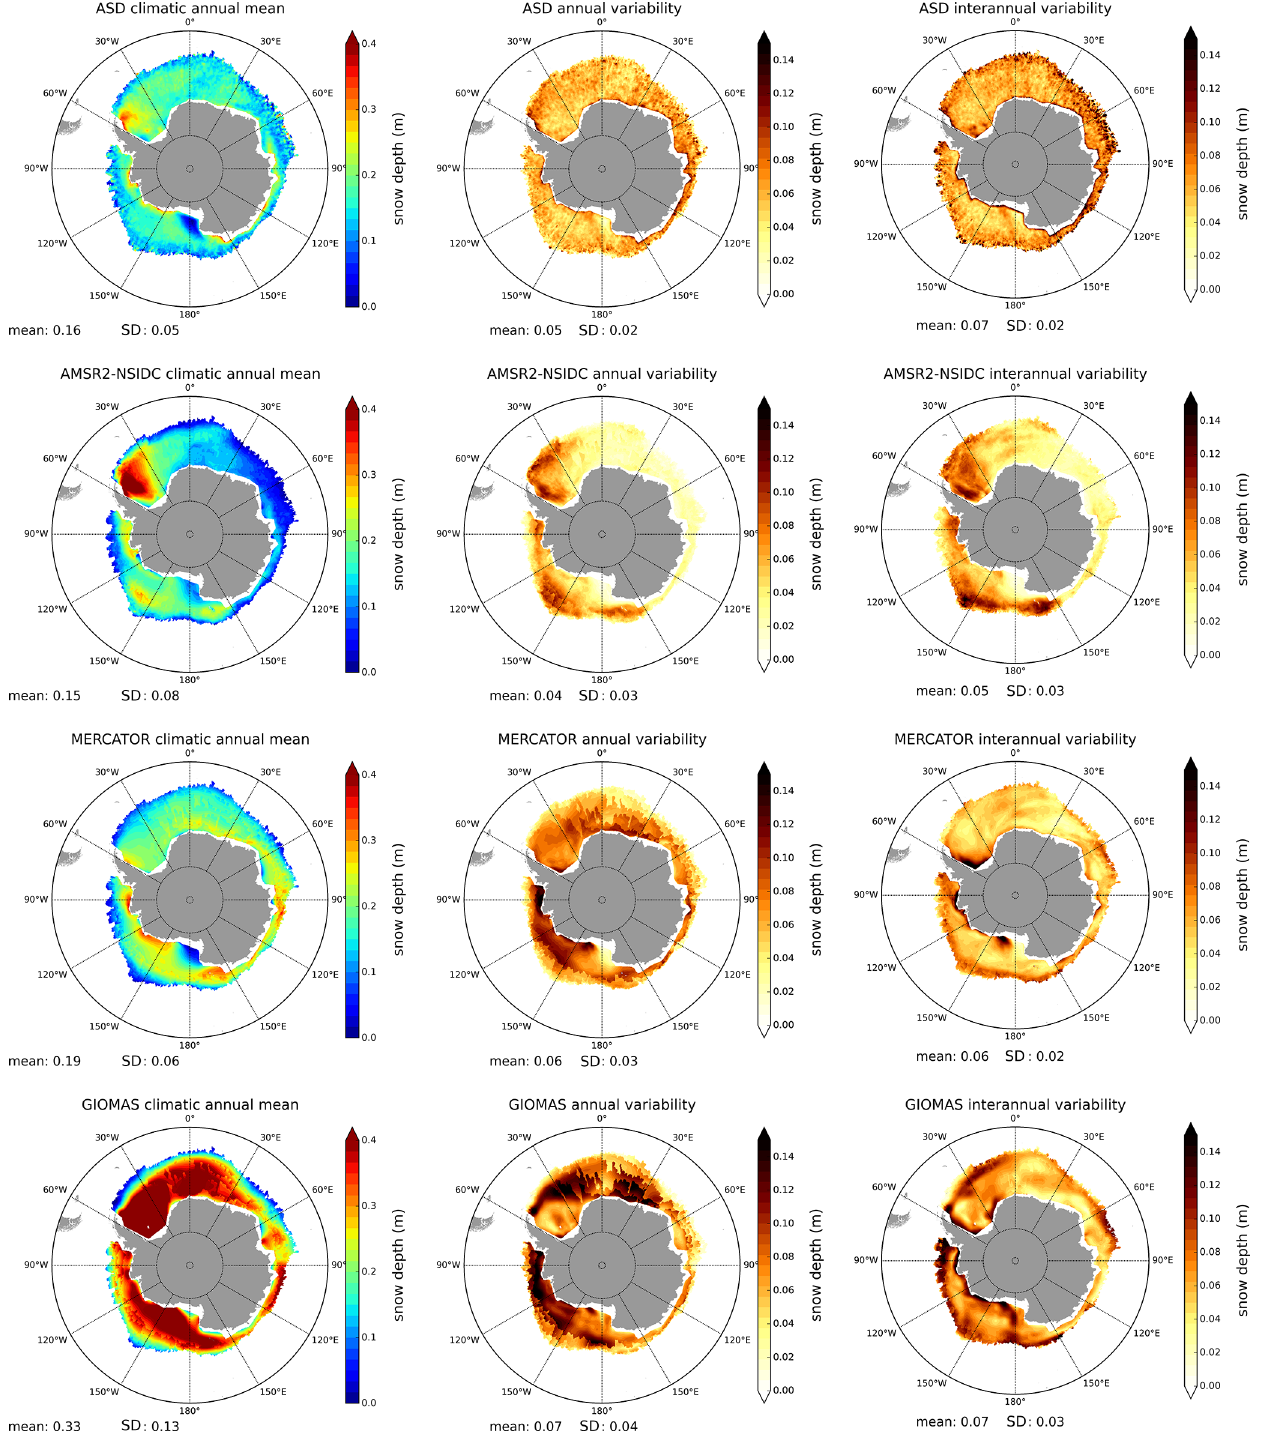
Figure 5. Comparisons between ASD data and other snow depth estimations in the Antarctic (AMSR2-NSIDC, MERCATOR, GIOMAS). The first column presents the “climatic mean” snow depth maps, the second column the “annual variability” and the third column the “interannual variability” as presented in Sect. 4.1. These diagnoses are calculated from May 2013 to October 2019 for the ASD data (first row), the AMSR2-NSIDC (second row) and the MERCATOR model (third row) and from May 2013 to October 2016 for the GIOMAS model data (fourth